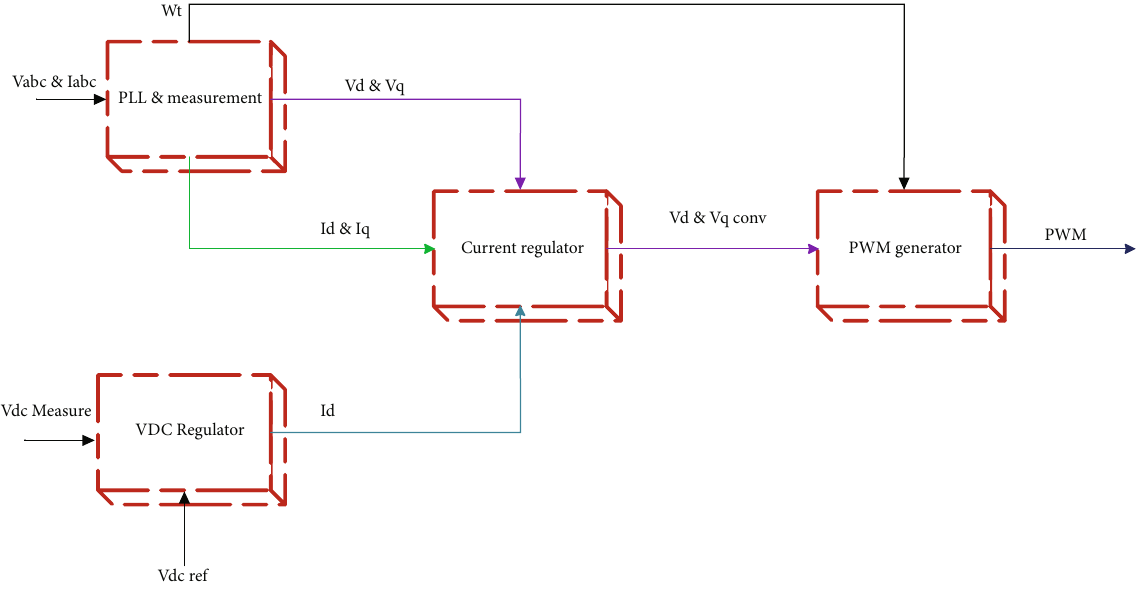
Figure 22: DNN controller-based voltage source controller for smart